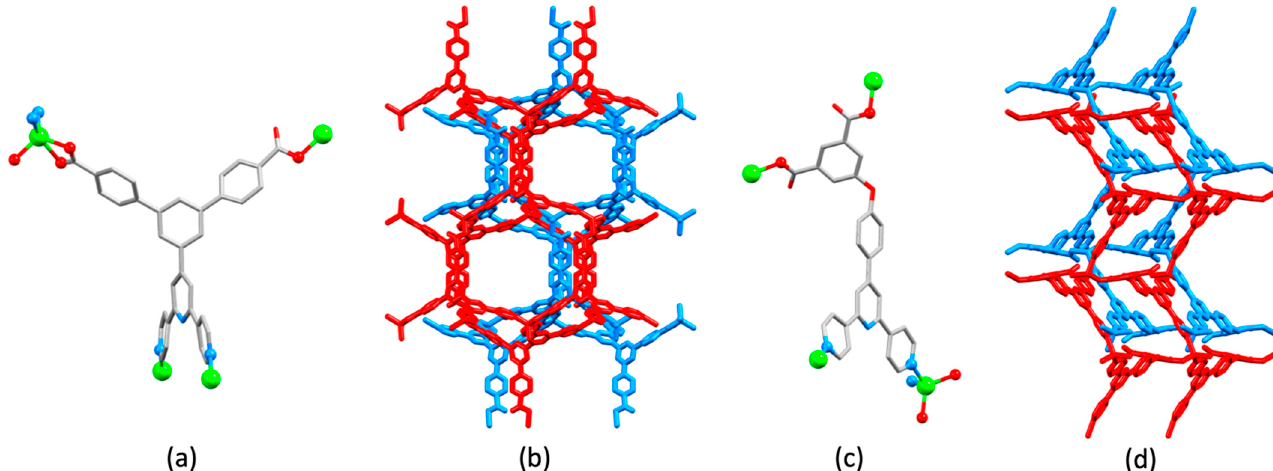
Figure 25. ( a ) The tetratopic binding-mode of 36 2– in [Zn( 36 )] n · 4 n DMF (CSD refcode QOZSIJ) and ( b ) the 2-fold interpene- Figure 25. (a) The tetratopic binding ‐ mode of 36 2– in [Zn( 36 )] n . 4 n DMF (CSD refcode QOZSIJ) and (b) the 2 ‐ fold interpene ‐ tration of lon -nets in [Zn( 36 )] n · 4 n DMF. ( c ) The 37 2– ligand is a 4-connecting node in [Zn( 37 )] n (refcode SAHWEG). ( d ) Part tration of lon ‐ nets in [Zn( 36 )] n . 4 n DMF. (c) The 37 2– ligand is a 4 ‐ connecting node in [Zn( 37 )] n (refcode SAHWEG). (d) Part of the 2-fold interpenetrating 3D-nets in [Zn( 37 )] n viewed down the crystallographic c of the 2 ‐ fold interpenetrating 3D ‐ nets in [Zn( 37 )] n viewed down the crystallographic c ‐ axis.